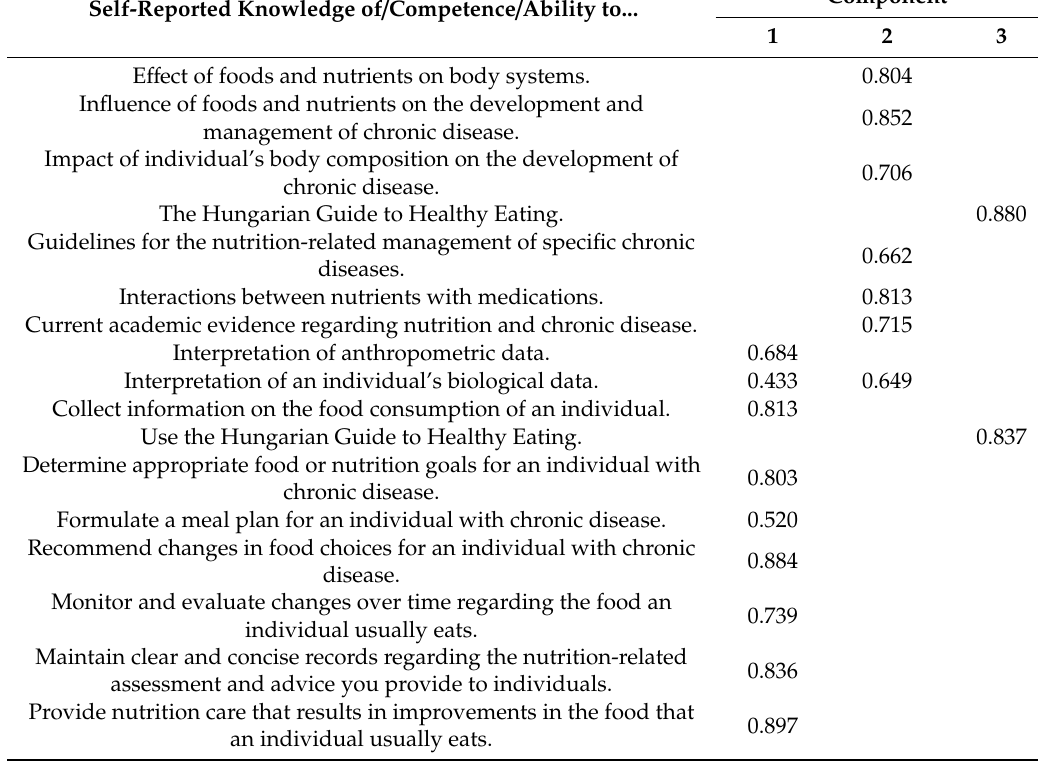
Table 4. Results of the factor analysis on nutrition-related knowledge and personalised nutrition-related